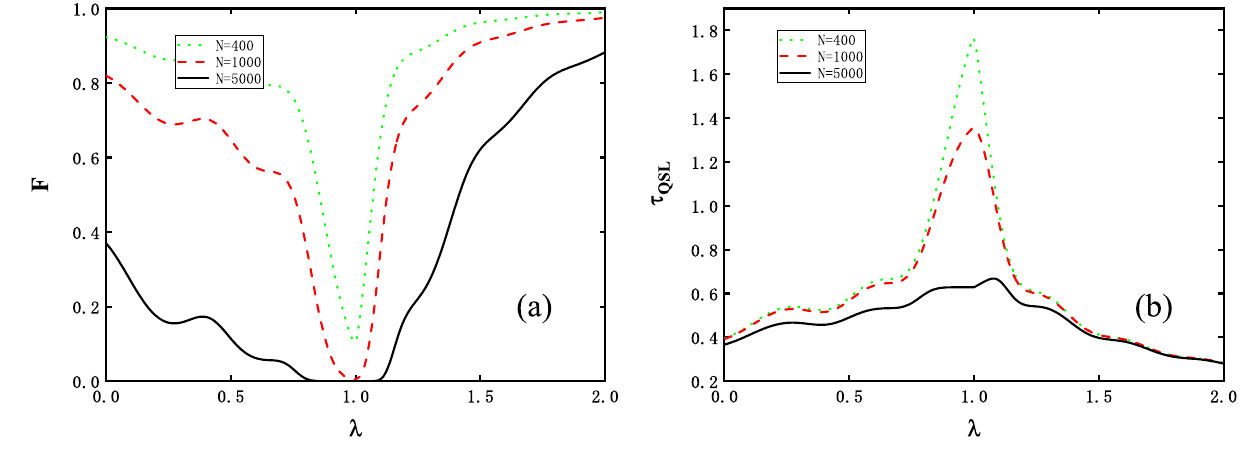
Figure 2. ( a ) The fidelity F and ( b ) the QSL time τ QSL as functions of the external field (cid:31) . Each different color line corresponds to the same colored line routine as in Fig. 1, i.e. N = 400, 1000, 5000 for green dotted, red dashed and black solid lines respectively. Here we set a fixed actual evolution time t = 5, weak perturbation 0.05 , and anisotropy value γ 1 . δ = =